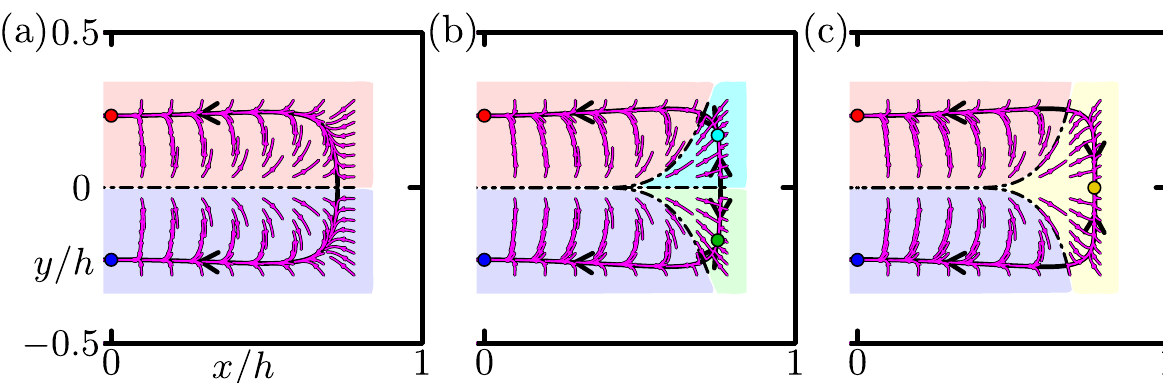
Figure 6. Trajectories of the particle centre projected over the cross-section (curves with arrows) and particle-focusing points (circles). Suspended particles located in each coloured region move towards the focusing point with the corresponding colour. The trajectories drawn by thick curves represents the pSS ring. Dash-dotted curves represent the separatrices. A = 2, d / h = 0.3125. ( a ) Re = 100, ( b ) Re = 255, ( c ) Re =